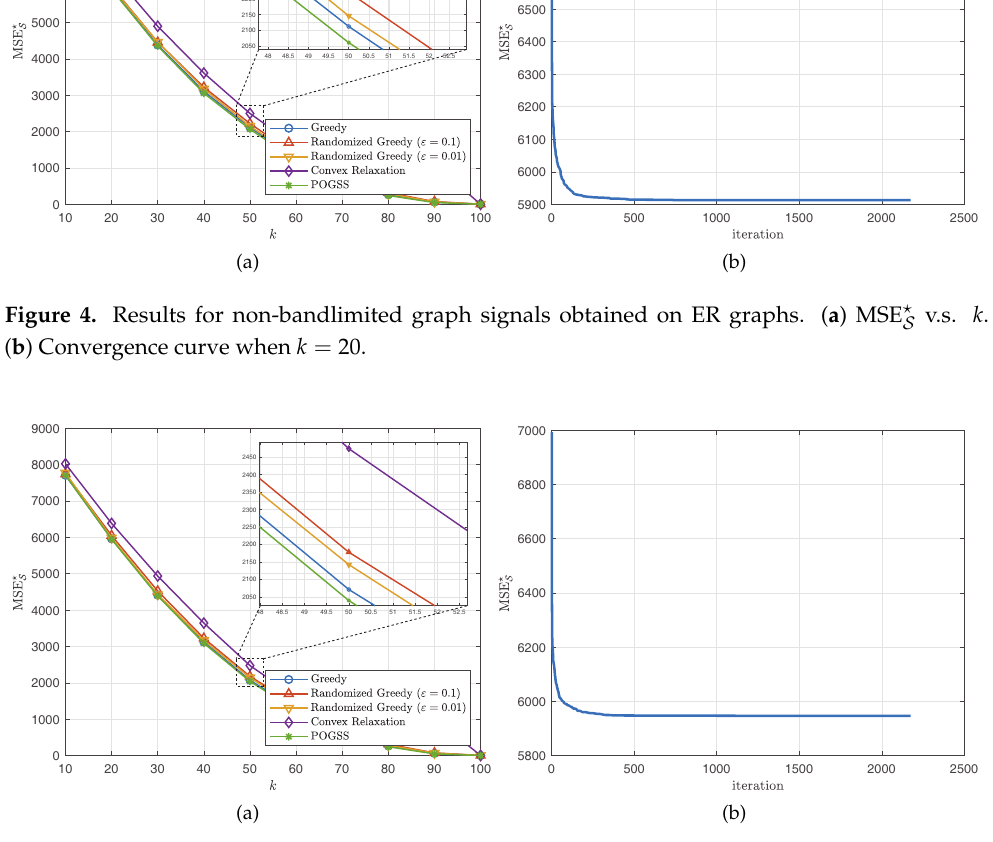
Figure 5. Results for non-bandlimited graph signals obtained on Gaussian graphs. ( a ) MSE (cid:63) S v.s. k . ( b ) Convergence curve when k =